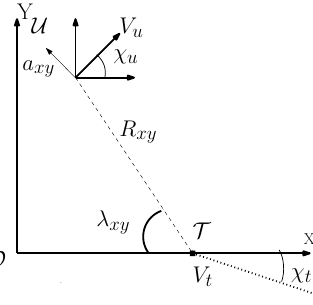
Figure A1. Planar engagement geometry of UAV